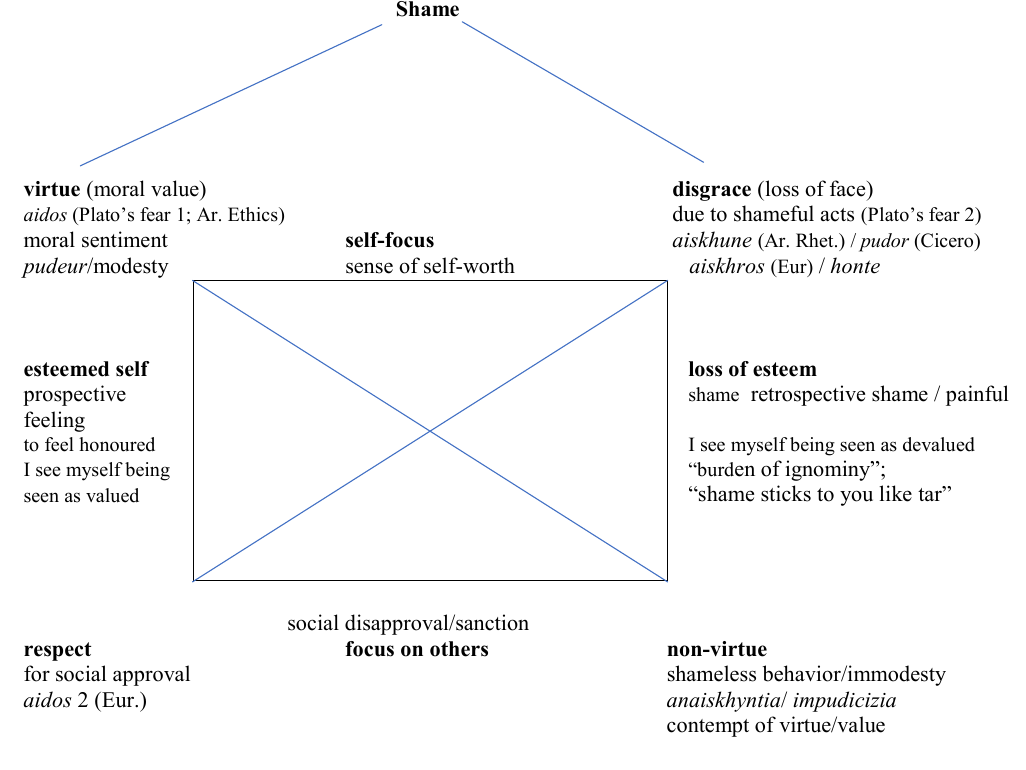
Fig. 1. The semiotic square of shame: shame is “masked and masking” (Wurmser, 1981: 15) In the top left corner, shame is shown as a moral value or virtue . In this positive sense, shame is a moral sentiment of modesty, and a self-conscious awareness of one’s own value implies respect for social approval ( prospective shame ). It is opposed to disgrace, shame and loss of face (top right), which imply